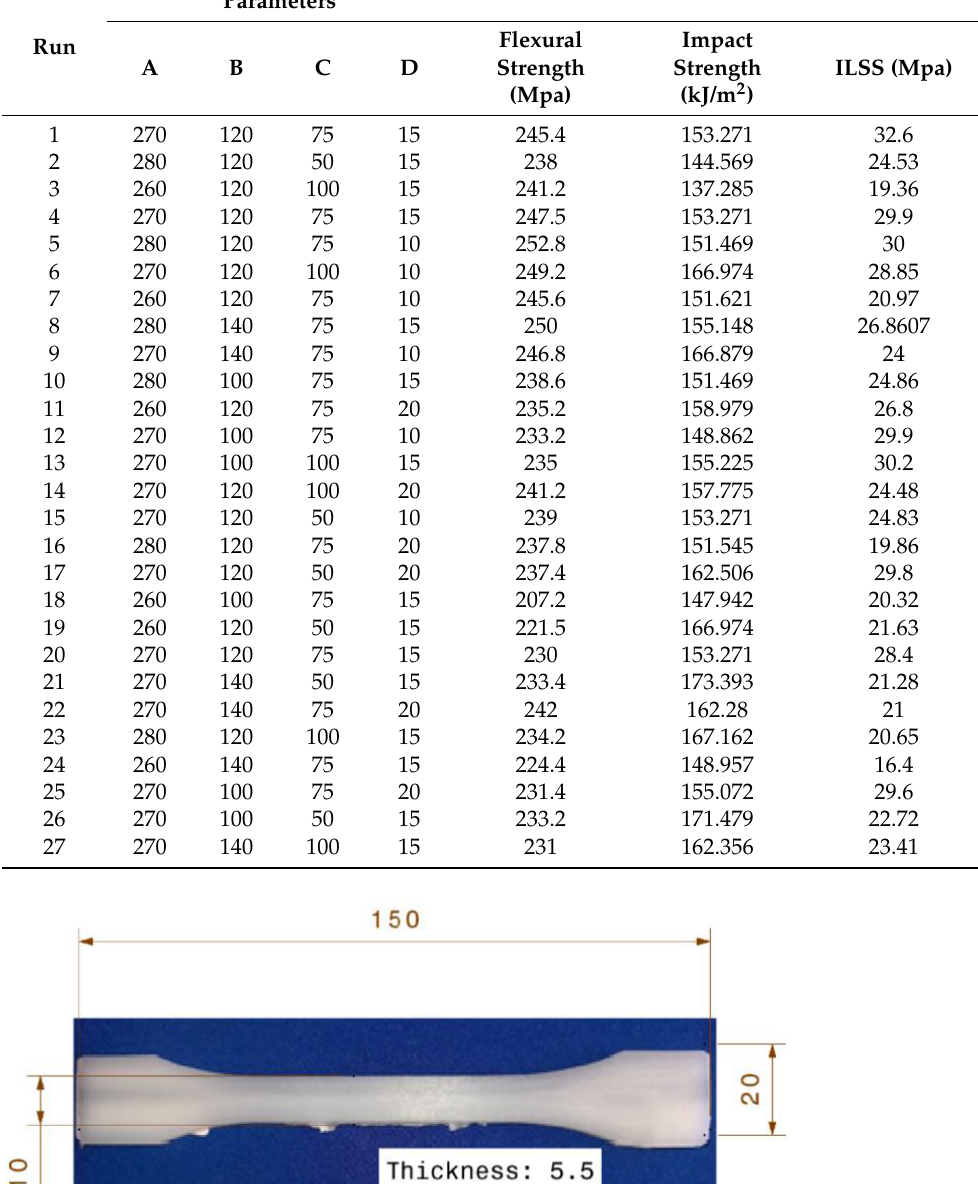
Table 5. Testing results.